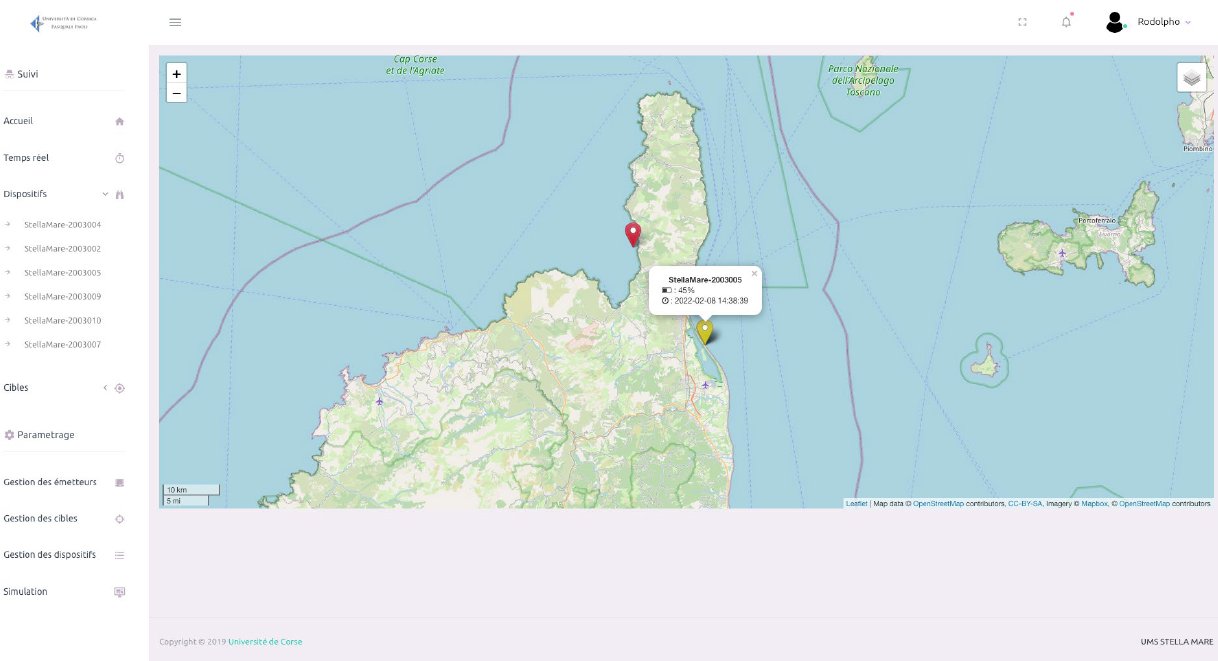
Figure 5. Screenshot of the main view of the monitoring interface. It provides a cartographic display as well as a sidebar displaying the status of receivers and transmitter IDs.